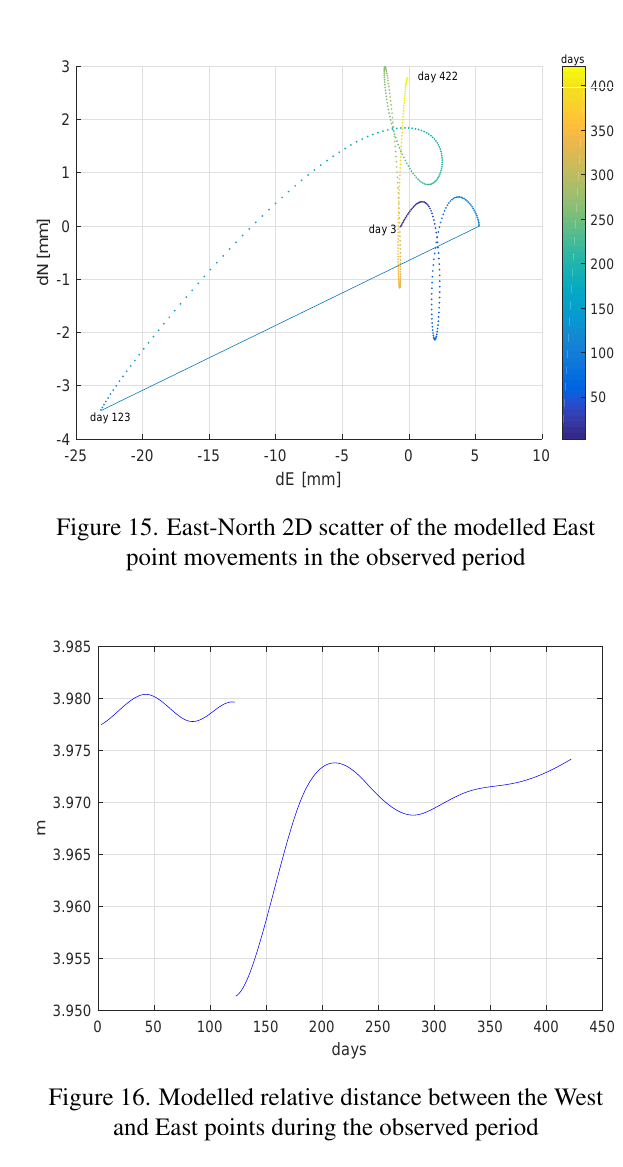
Figure 14. East-North 2D scatter of the modelled West point movements in the observed period